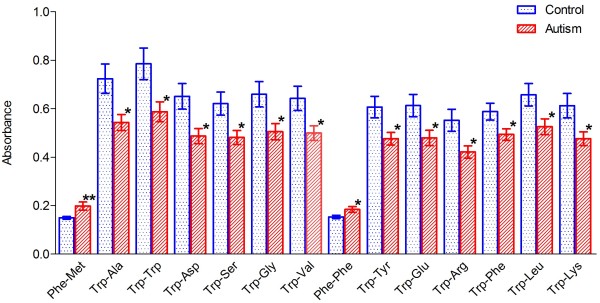
Histogram of energy metabolism in the ASD cells vs. control cells. The bar height of the histogram indicates the mean of measurements of 20 cell lines for each group; vertical bars are standard errors of the means. Star* symbol denotes level of statistical significance determined by a t test: **P <0.01; *P <0.05. The substrates were ordered according to their individual P values with the lowest on the left.